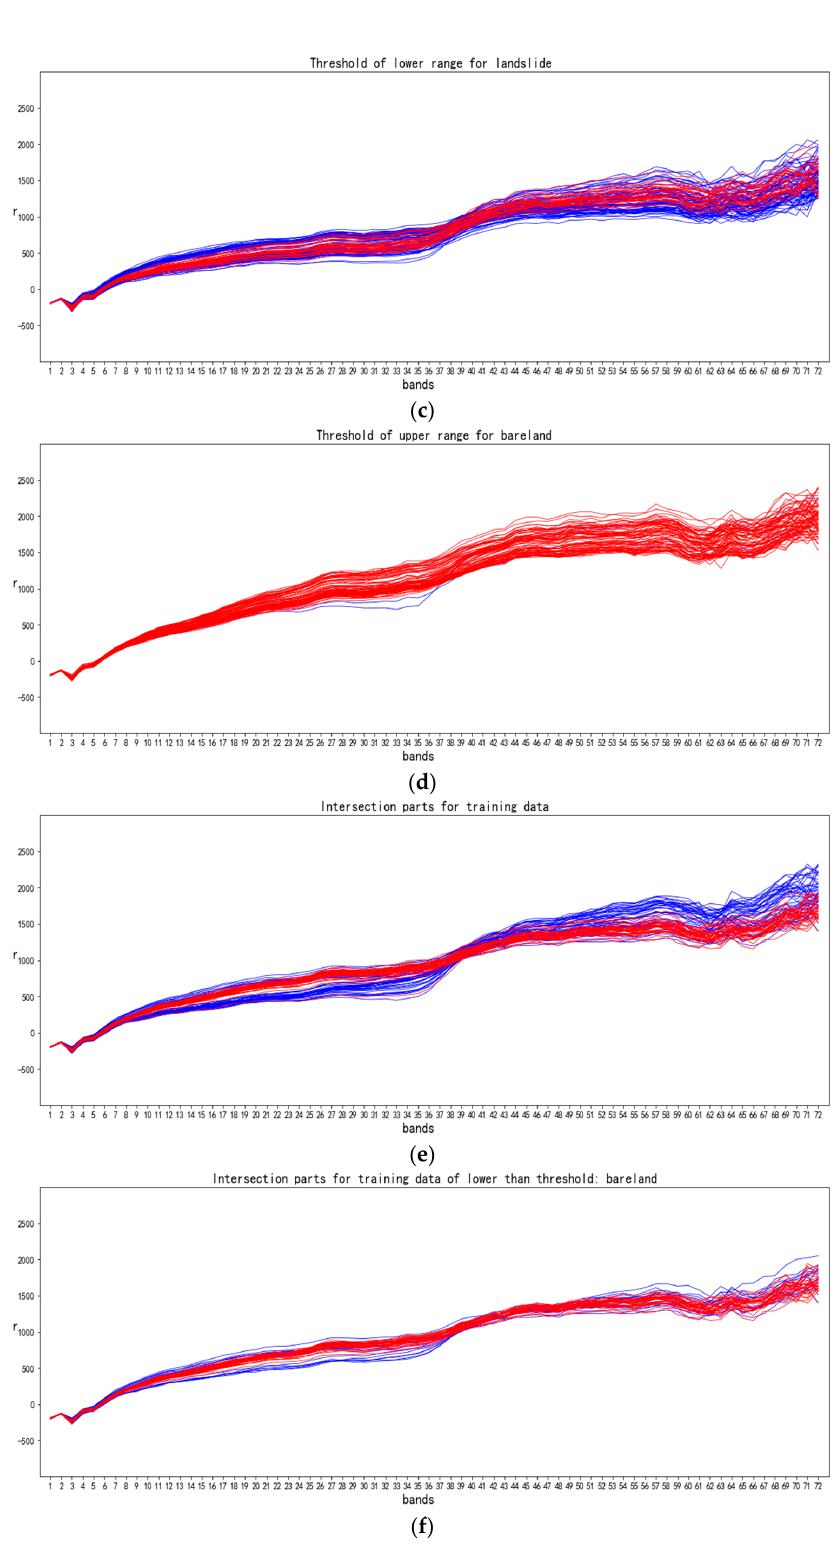
Figure 6. ( a ) three different categories for classification; ( b ) threshold of upper range for vegetation and non-vegetation; ( c ) the lower range on the threshold for landslide; ( d ) the upper range on the threshold for bareland; ( e ) intersection parts for training data of larger than threshold: landslide; ( f ) intersection parts for training data of lower than threshold: bareland (green: vegetation; blue: landside; red: